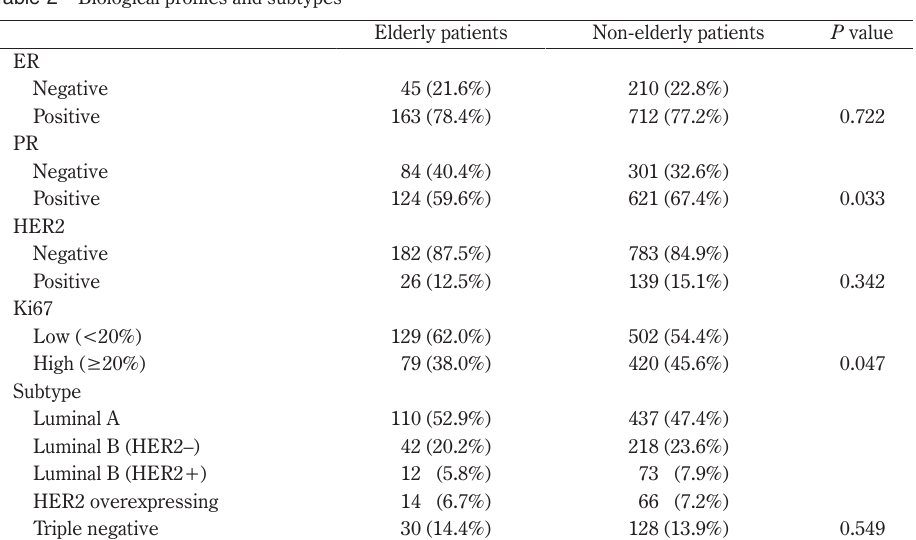
Table 2 Biological profiles and subtypes